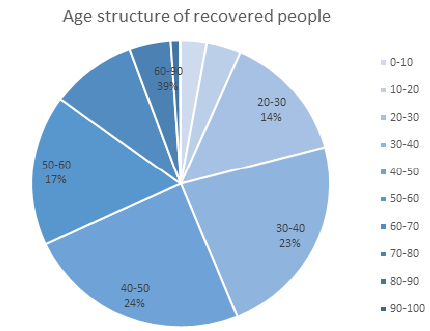
Figure 4. Age structure of recovered